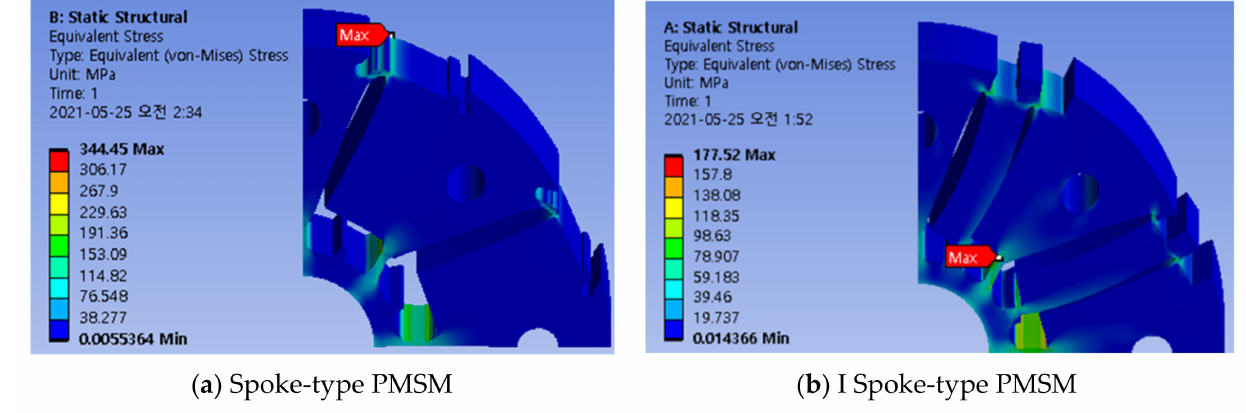
Figure 21. Stiffness analysis result for each model at 18,000